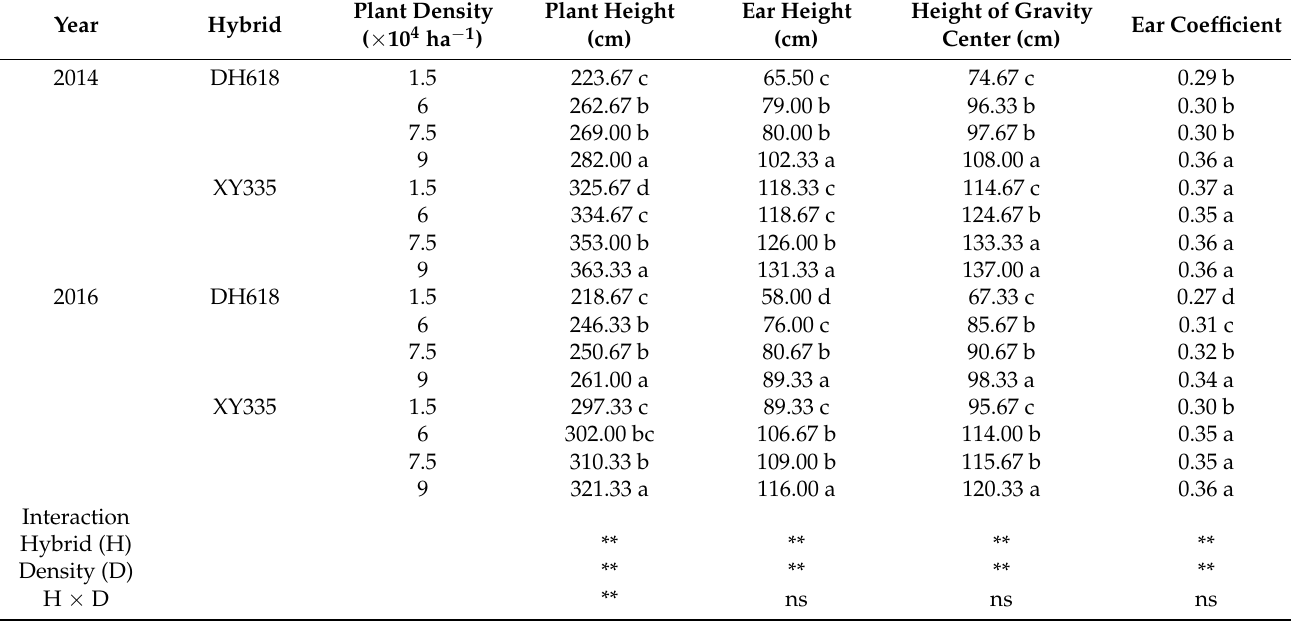
Table 4. Plant morphological characteristics of DH618 and XY335 under different planting densities in 2014 and